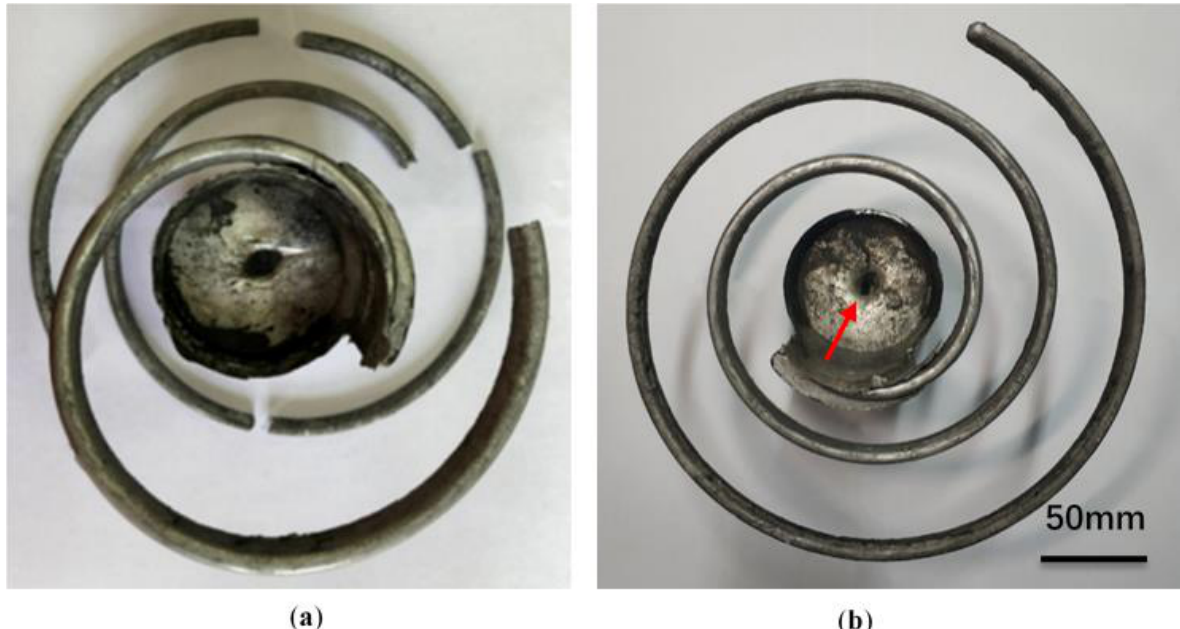
Figure 1. Macrographs of ZL205A alloy samples produced by squeeze casting with different extrusion pressures: ( a ) 30 MPa; ( b ) 60 MPa.